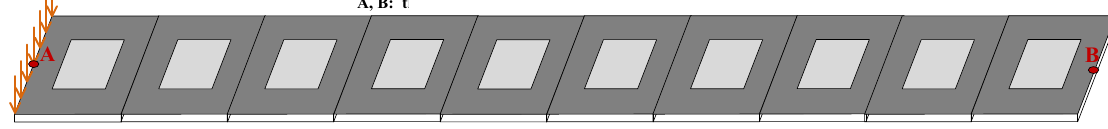
Figure 4. The finite phononic plate composed of 1 × 10 unit cells.